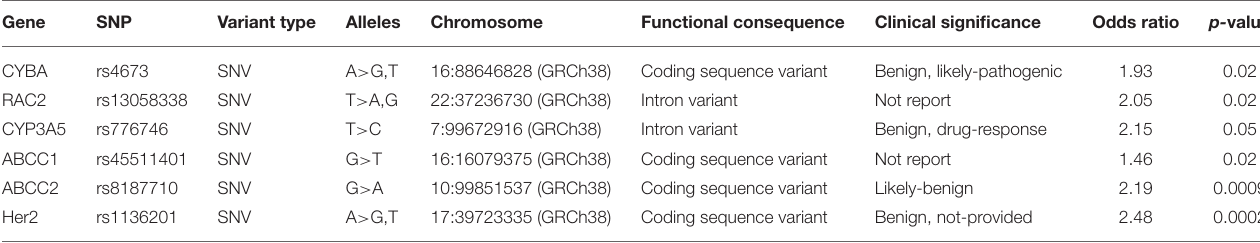
TABLE 3 | The 6 variants, annotations and meta-analysis OR and p- value. Gene SNP Variant type Alleles